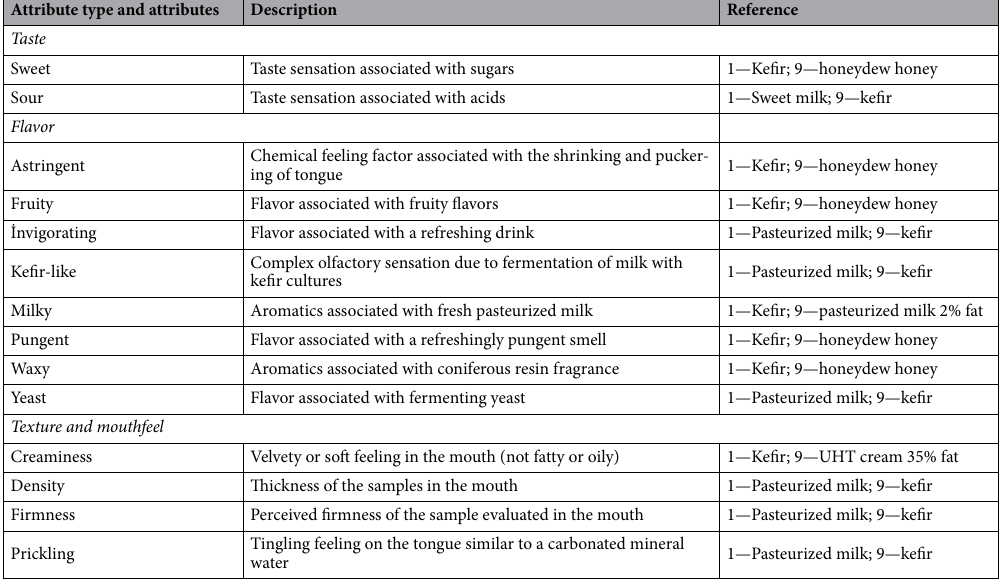
Table 1. Sensory attributes and description used to characterize kefir with honey.